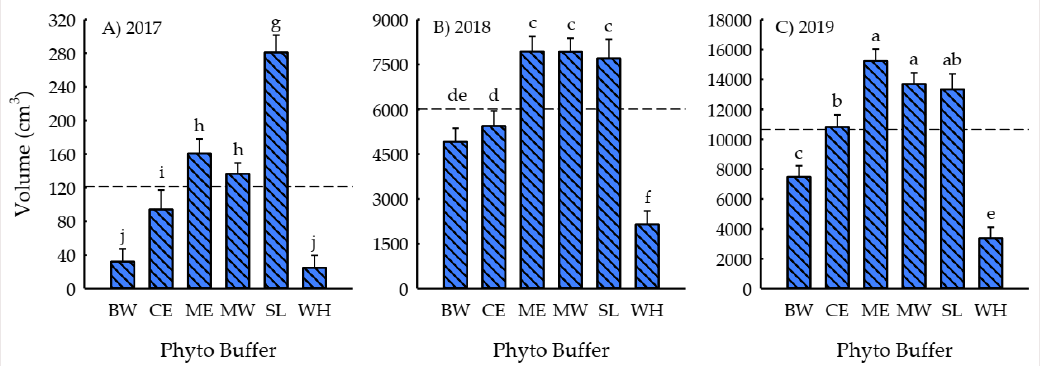
Figure 5. First- ( A ), second- ( B ), and third-year ( C ) volume ( ± one standard error) of six phytoremediation buffers (i.e., phyto buffers) established in 2017 (i.e., the 2017 Buffer Group) in the Lake Michigan watershed of eastern Wisconsin, USA. The dashed line represents the overall mean, and asterisks indicate means different than the overall mean at p < 0.05. Bars with different letters across all buffer × year combinations are different at p <